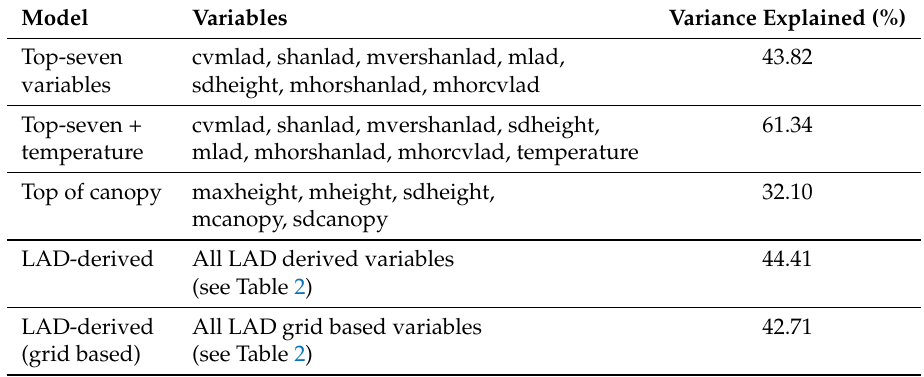
Table 3. Accuracy of the random forests (RF) models for bird species’ richness.